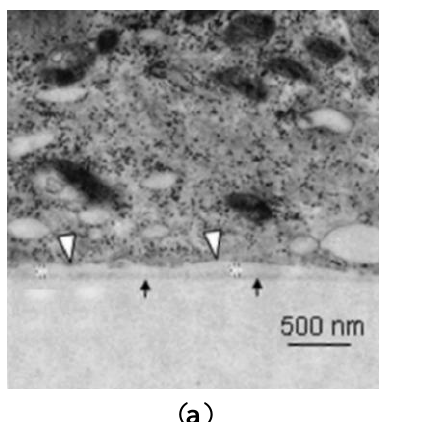
Figure 7. TEM images showing examples of cell-substrate clefts—from [75]. Cells have been fixed and sectioned using a focussed ion beam: ( a ) A platinum substrate (the surface marked with black arrows) was coated with laminin-111 prior to adhesion of chicken embryo neurons. The cleft is between the adhered cell membrane (marked by white arrows) and the platinum surface and was measured to be 27–108 nm; ( b ) L1 Ig6 (the sixth immunoglobulin domain of cell adhesion molecule L1 and known to promote neurite extension) has a lower molecular weight (8 kDa) and is a smaller molecule than laminin-111 (~800 kDa). Smaller molecules generally result in smaller clefts, as illustrated here by the cleft of 26–79